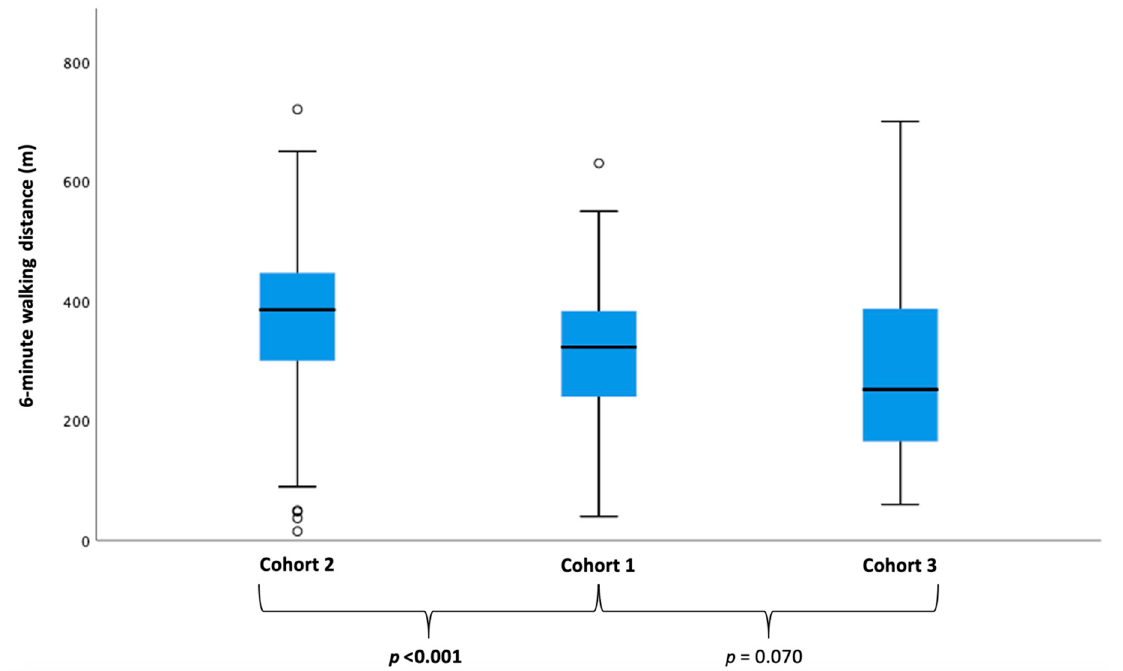
Figure 3. Between-cohort differences in exercise capacity. Boxplots showing median 6-min walking distances of the PARAGON-like proportion of the real-world HFpEF cohort ( Cohort 1 ), patients who did not meet the inclusion criteria ( ± fulfilled exclusion criteria) ( Cohort 2 ) and patients who would have been excluded ( Cohort 3 ). Kruskal–Wallis test was performed and showed a significant difference across the different cohorts ( p < 0.001).